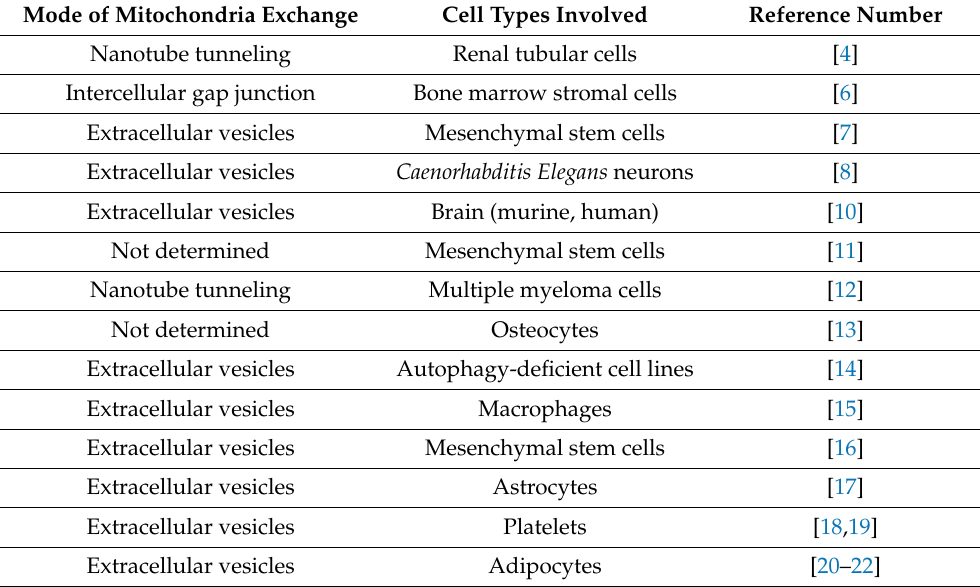
Table 1. Three different modes of mitochondria transfer have been identified, including direct cell/cell connection by nanotubes, formation of intercellular gap junctions or liberation of extracellular mitochondria-containing vesicles. The table presents a summary of the mode of mitochondria exchange in different cell types from published studies indicated by reference